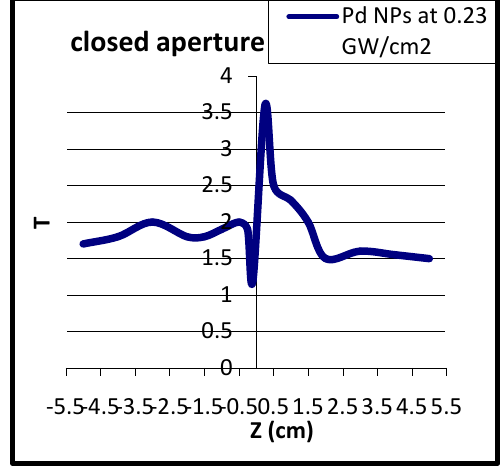
Fig.8: Closed-aperture Z-Scan at 532